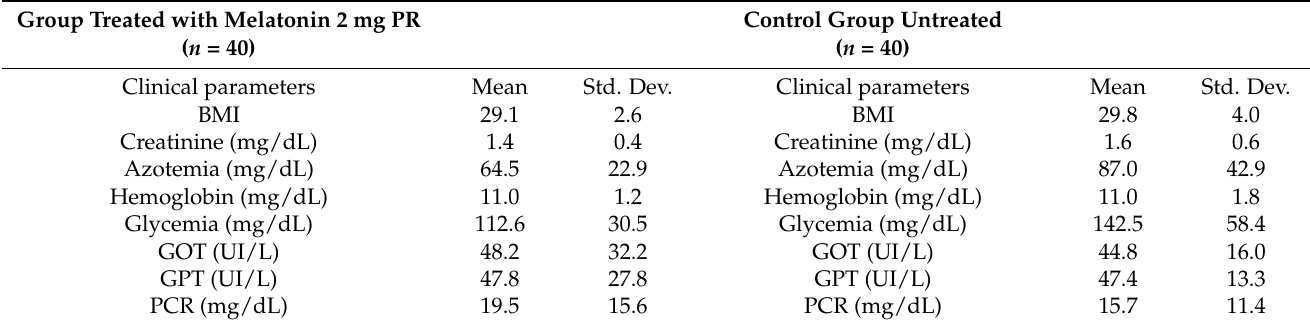
Table 1. Clinical and blood parameters of two groups.